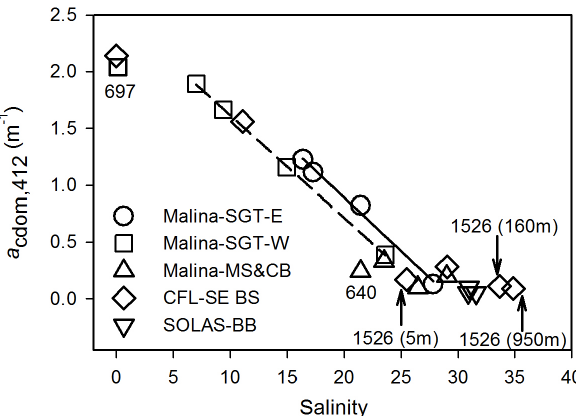
Fig. 2. Scatter plot of CDOM absorption coefficient at 412nm ver-